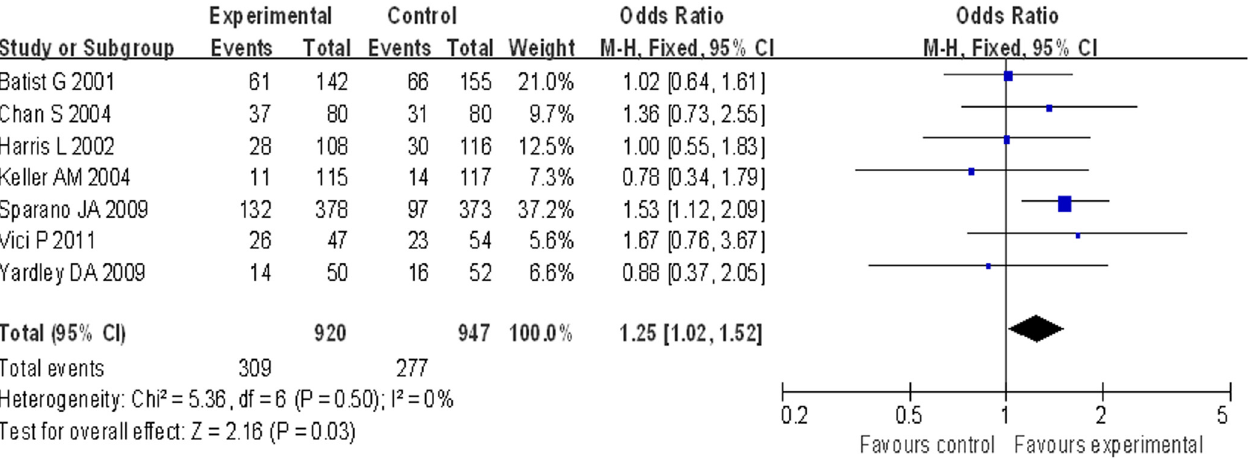
Fig 2. Forest plot of ORR comparison between two groups.